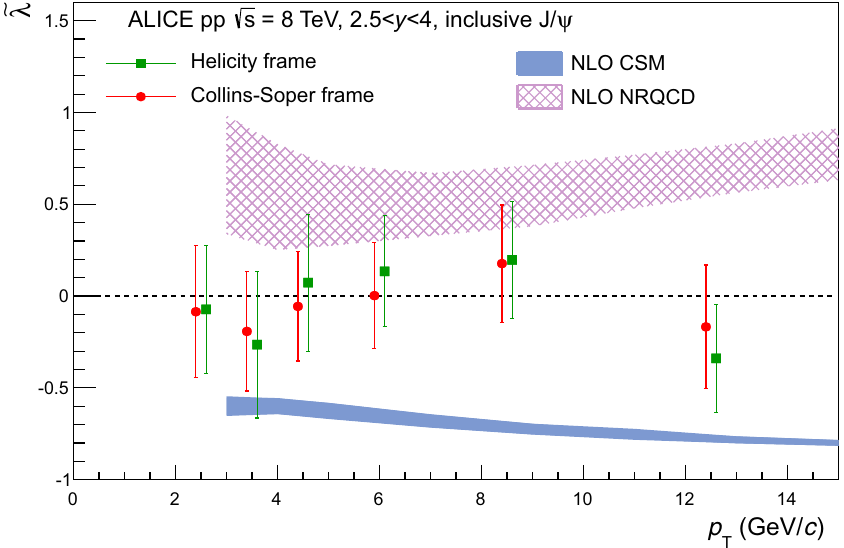
Fig. 5 Inclusive J/ ψ frame-invariant quantity (cid:6) λ in pp √ s = 8 TeV in the collisions at Collins-Soper (red points, shifted horizontally by − 0 . 1 GeV / c ) and helicity (green squares, shifted horizontally by + 0 . 1 GeV / c ) frames compared with the NLO CSM (blue full band) and NRQCD (red shaded band) model predictions from [10]